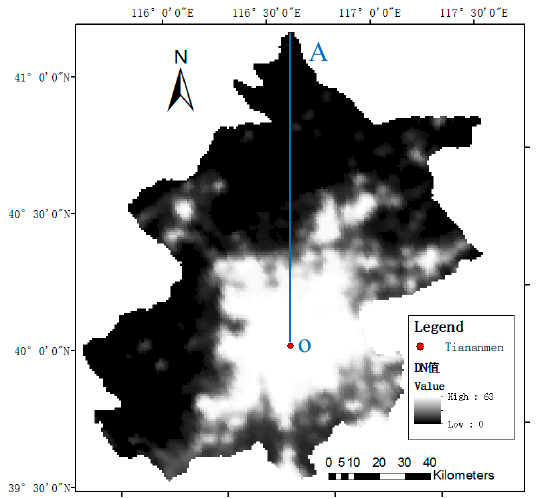
Figure 2. Defense Meteorological Satellite Program (DMSP)/Operational Linescan System (OLS) nighttime light data of Beijing in 2013.